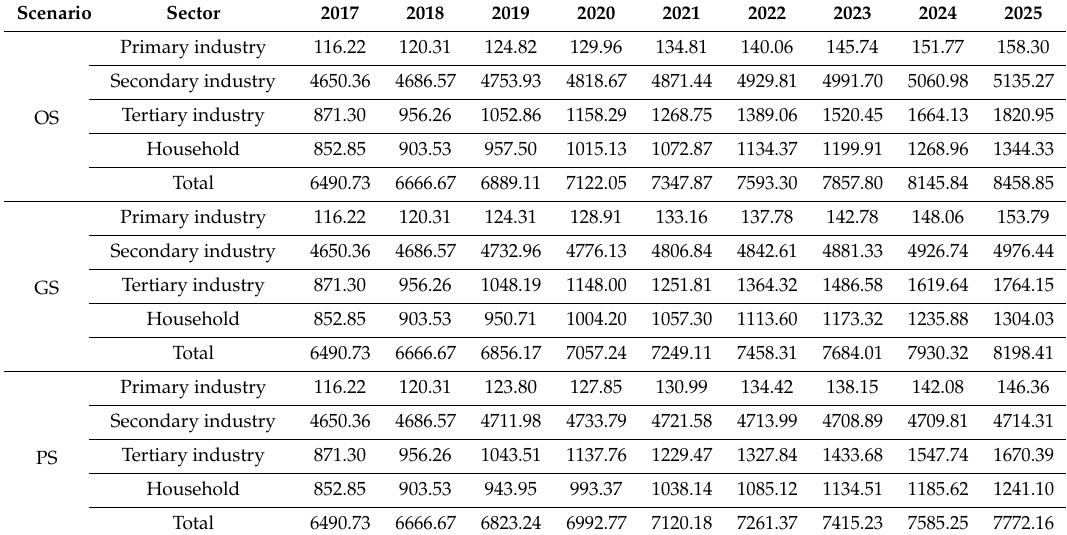
Table 3. Electric consumption of the whole nation and di ff erent sectors (Unit: billion kW · h). OS: optimistic scenario, GS: general scenario, PS: pessimistic scenario.